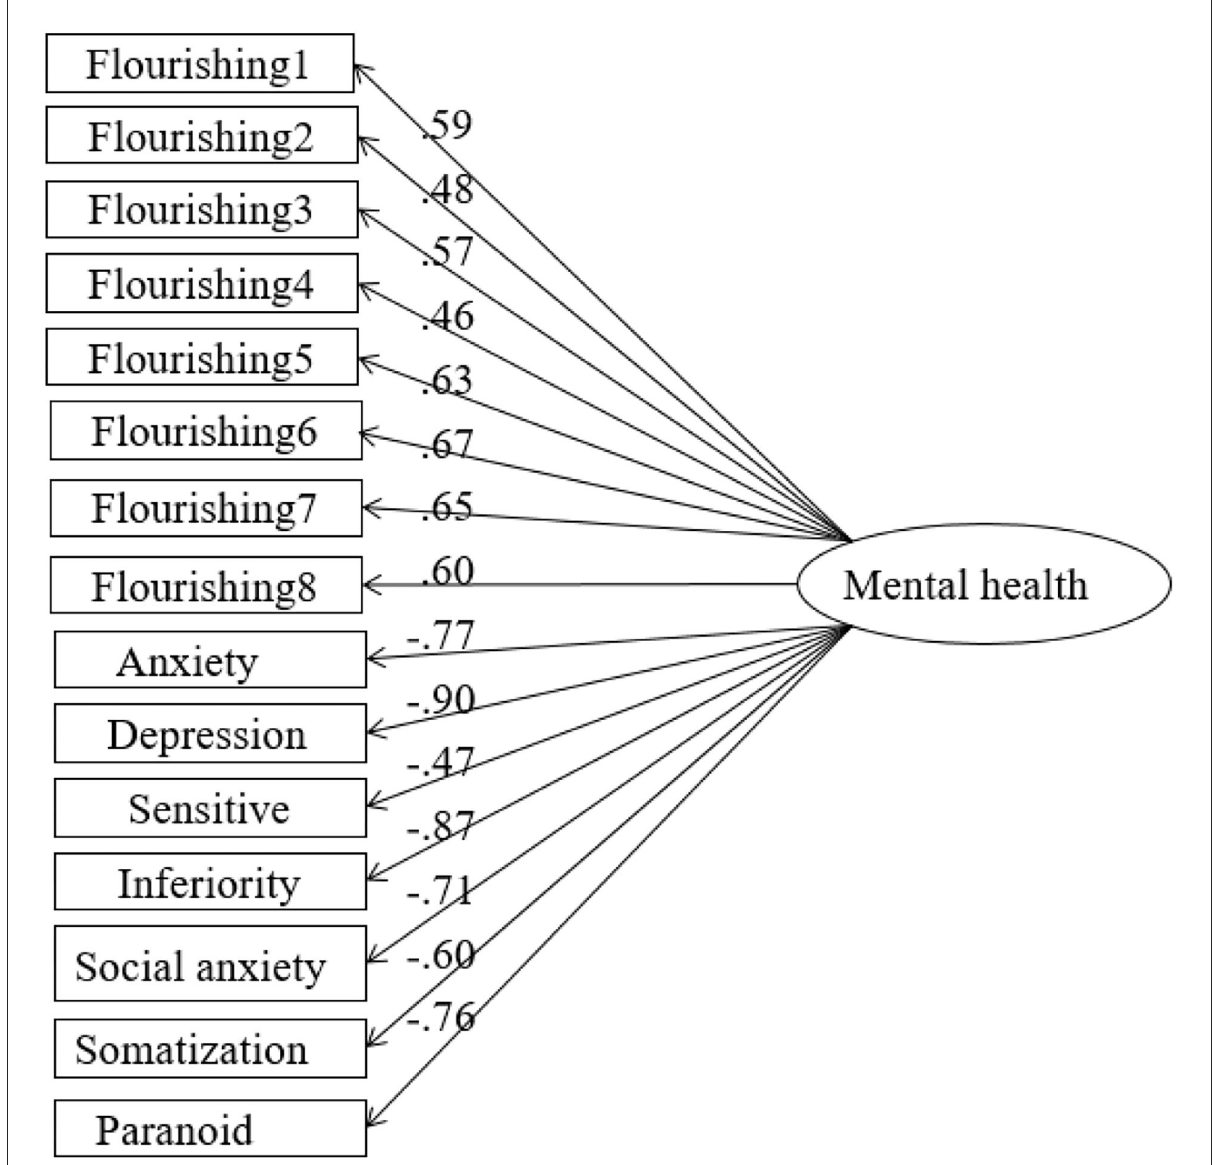
FIGURE3 Fitting path data of the one-factor mental health